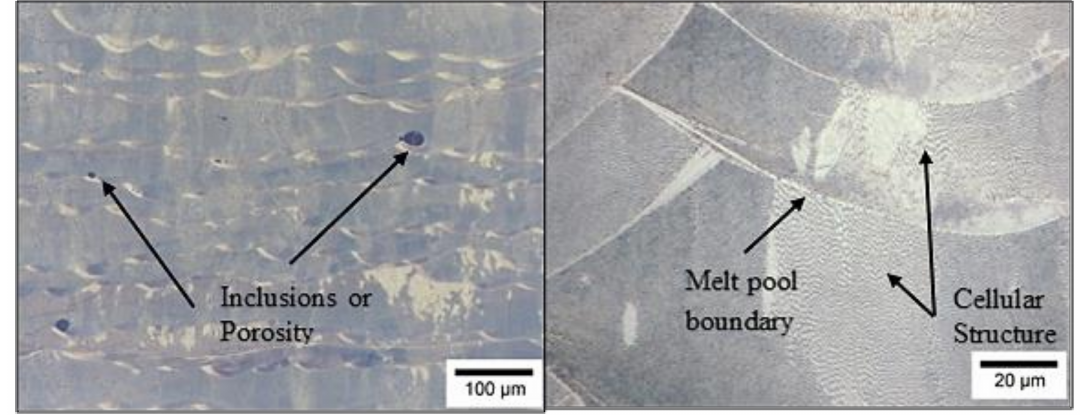
Figure 7. Optical images of SLM 304L in two magnifications etched with a 60:40 water: nitric acid electrolytic